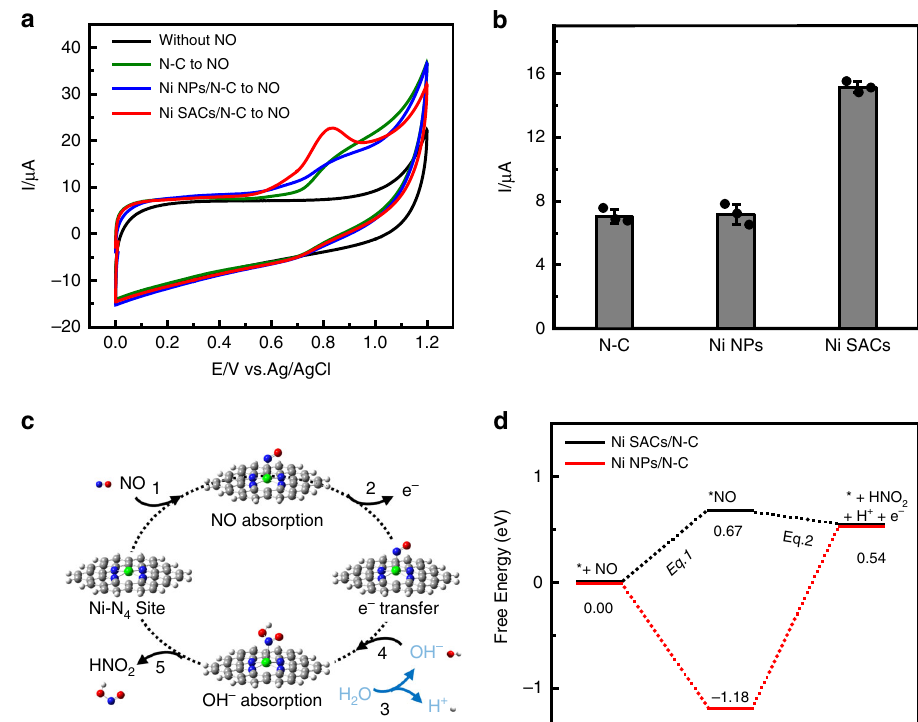
Fig. 3 Performance and mechanism of Ni SACs/N-C for electrocatalytic NO oxidation. a Cyclic voltammograms obtained at glassy carbon electrodes modi fi ed with Ni SACs/N-C (red curve), Ni NPs/N-C (blue curve) or N-C (green curve) in deaerated phosphate − buffered solution (PBS) containing 0.18 mM NO. Black curve represents a control experiment of Ni SACs/N-C in deaerated PBS without NO. b Data are represented as current response recorded with three different modi fi ed electrodes shown in (a). Error bars = standard deviation ( n = 3). c The proposed structures for electrocatalytic oxidation process of NO on Ni SACs/N-C. d The Gibbs free energy pro fi le along the pathway from NO to HNO 2